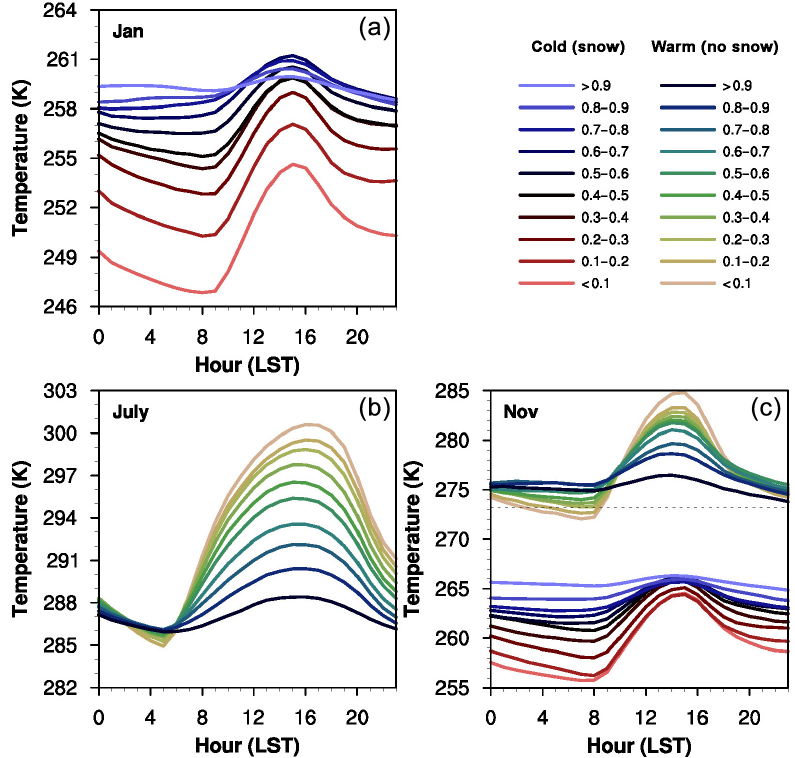
Figure 11. Land surface hydrological processes and atmospheric (boundary layer) processes do not proceed in isolation from each other; land states and boundary layer states evolve together, as a joint system. The nature of this coupled system was recently elucidated through a careful analysis of a wealth of land surface and boundary layer data collected by trained observers in the Canadian Prairies. These observers recorded hourly, since 1953, the fraction of the sky covered by opaque reflective cloud, providing daily shortwave and longwave cloud forcing (SWCF and LWCF) on climate timescales when calibrated against baseline surface radiation measurements (Betts et al., 2015). The panels above express some of the important relationships inherent in these data in the form of average diurnal temperature cycles for January (a) , July (b) , and the fall transition month of November (c) . For each month, days are binned by daily mean opaque cloud fraction in tenths, with a different color scheme for cold days with mean temperature <0 ◦ C and snow cover, and days >0 ◦ C and no snow cover. In July, the diurnal cycle of temperature and relative humidity is dominated by SWCF on both daily and monthly timescales, and temperatures rise under clear skies. In contrast, in January, the temperatures are lower under clear skies as LWCF dominates (Betts et al., 2014a, 2015). It is in fact the presence or absence of reflective snow cover that determines the impact of clouds on surface temperature – in November, the snow-free days are more than 10K warmer than the snow-covered days, and the former shows the July type of behavior, whereas the latter shows the January type of behavior. (Contact: Alan Betts. Adapted from Betts and Tawfik,